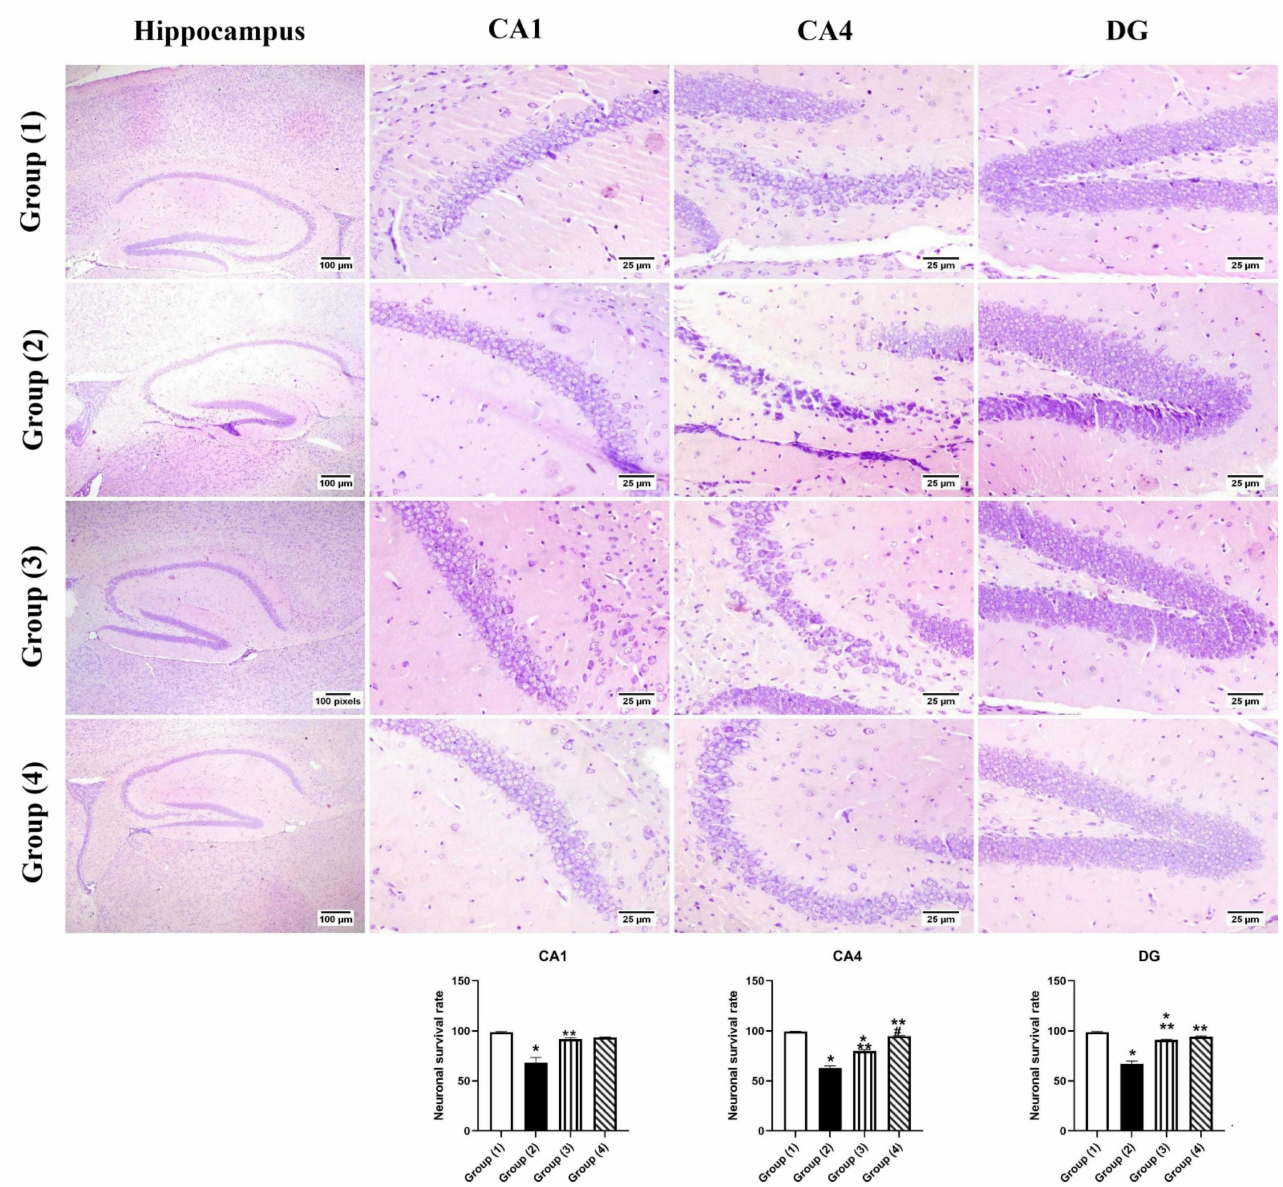
Figure 7. Photomicrograph of brain, hippocampus region (Cresyl violet stain), showing intact neurons within the different hippocampus regions in group (1), group (2) showed dark stained degenerated neurons within hippocampus regions, groups (3) and (4) showed apparently normal hippocampus. Charts represent neuronal survival rates, data expressed as means ± SE. Significant difference was considered at p < 0.05. *: Statistically significant different from the normal group at p < 0.05, **: Statistically significant different from the positive control group (STZ, 3 mg/kg) at p < 0.05. #: Statistically significant different from luteolin suspension group (50